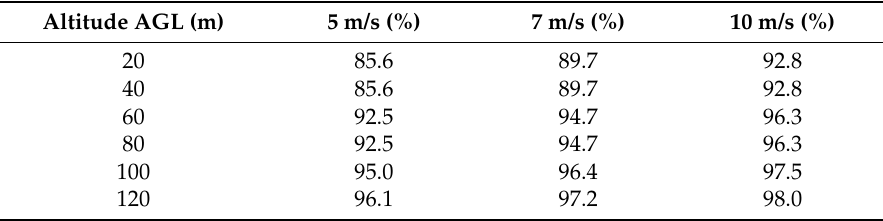
Table 3. Improved productivity of UAV inspection work versus manual